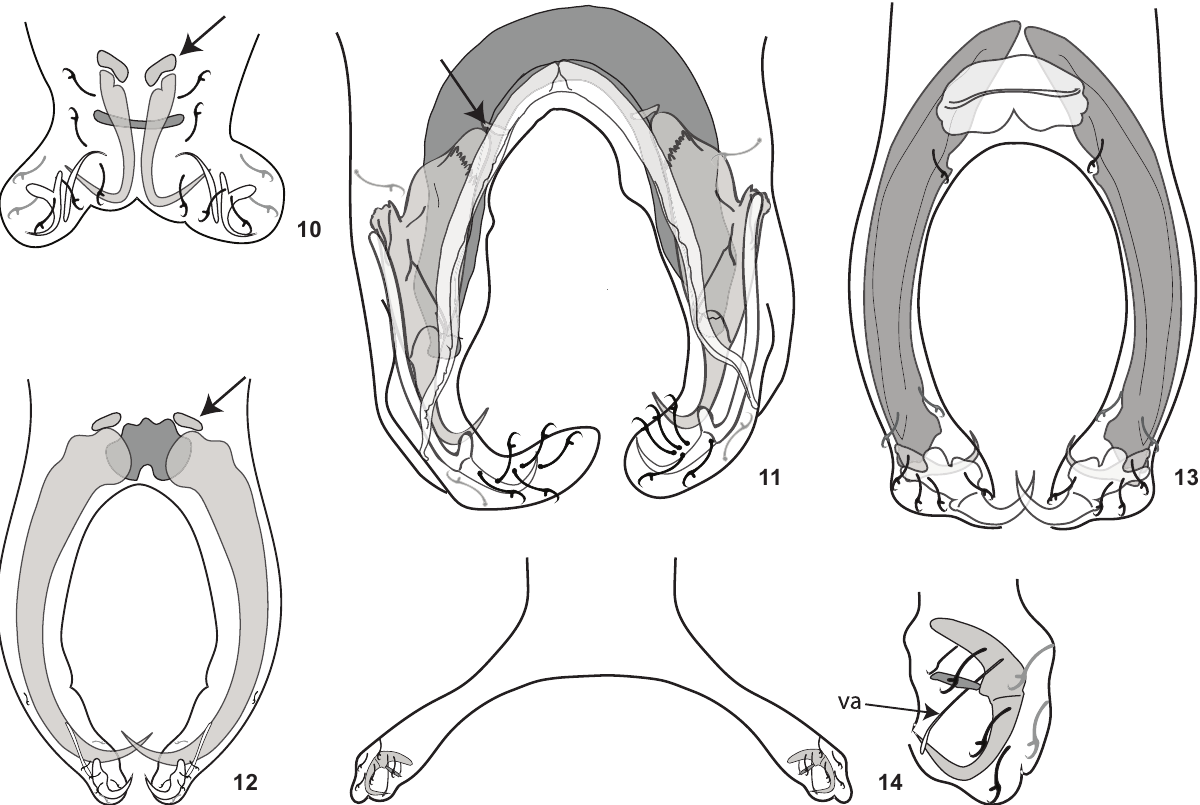
Figures 10-14. Morphology and organization of the haptoral armature of different groups of Dactylogyrinea: (10) haptoral armature of Cornudiscoides bagri Lim, 1987 modified from L IM (1987); (11) haptoral armature of Susanlimae ianwhittingtoni sp. nov. ; (12) haptoral armature of Bifurcohaptor modified from K EARN & B IJUKUMAR (1997); (13) haptoral armature of Furcohaptor cynoglossi modified from B IJUKUMAR & K EARN (1996); (14) haptoral armature of Aetheolebes goldiensis modified from B OEGER & K RITSKY (2009). Ventral sclerites are clear; light gray indicates the dorsal anchor; dark gray indicates dorsal bar; black hooks are ventral; gray hooks are dorsal. Arrows indicate the accessory sclerite; va = reduced ventral anchor. Figures are not to scale. Number and/or distribution of hooks in figures 10, 12, 13 are merely illustrative, as they were not confirmed in type or voucher